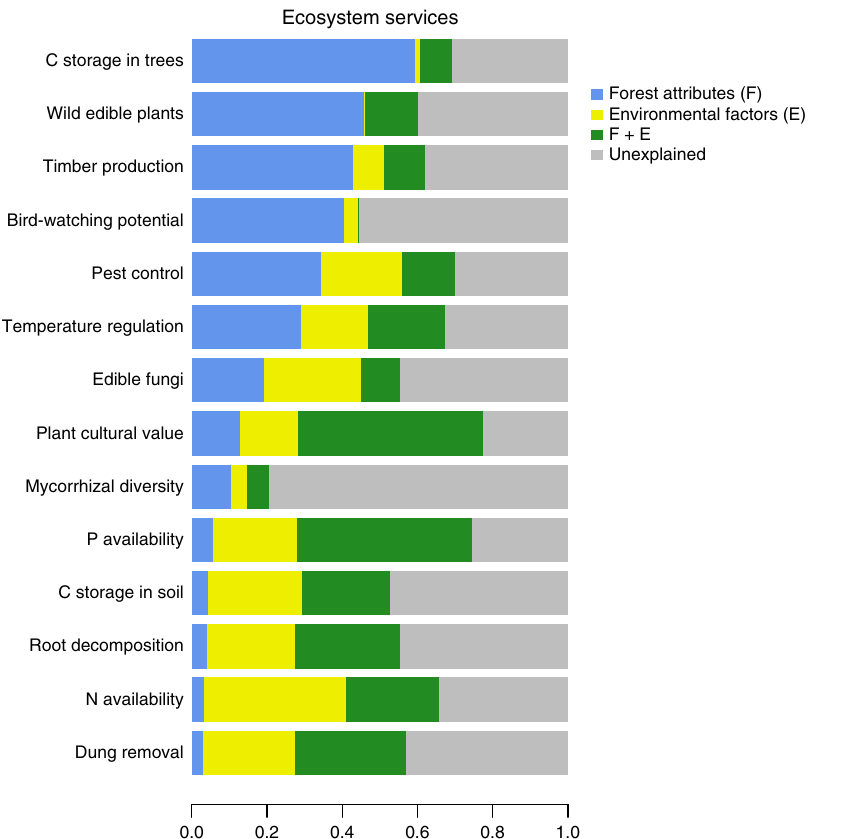
Fig. 1 Importance of forest attributes and environmental factors for explaining ecosystem services. Bars show the variance exclusively explained by forest attributes and environmental factors, the shared variance between them and the unexplained variance. See Supplementary Table 2 for sample size in each ecosystem service model and Supplementary Fig. 3 for correlation among all